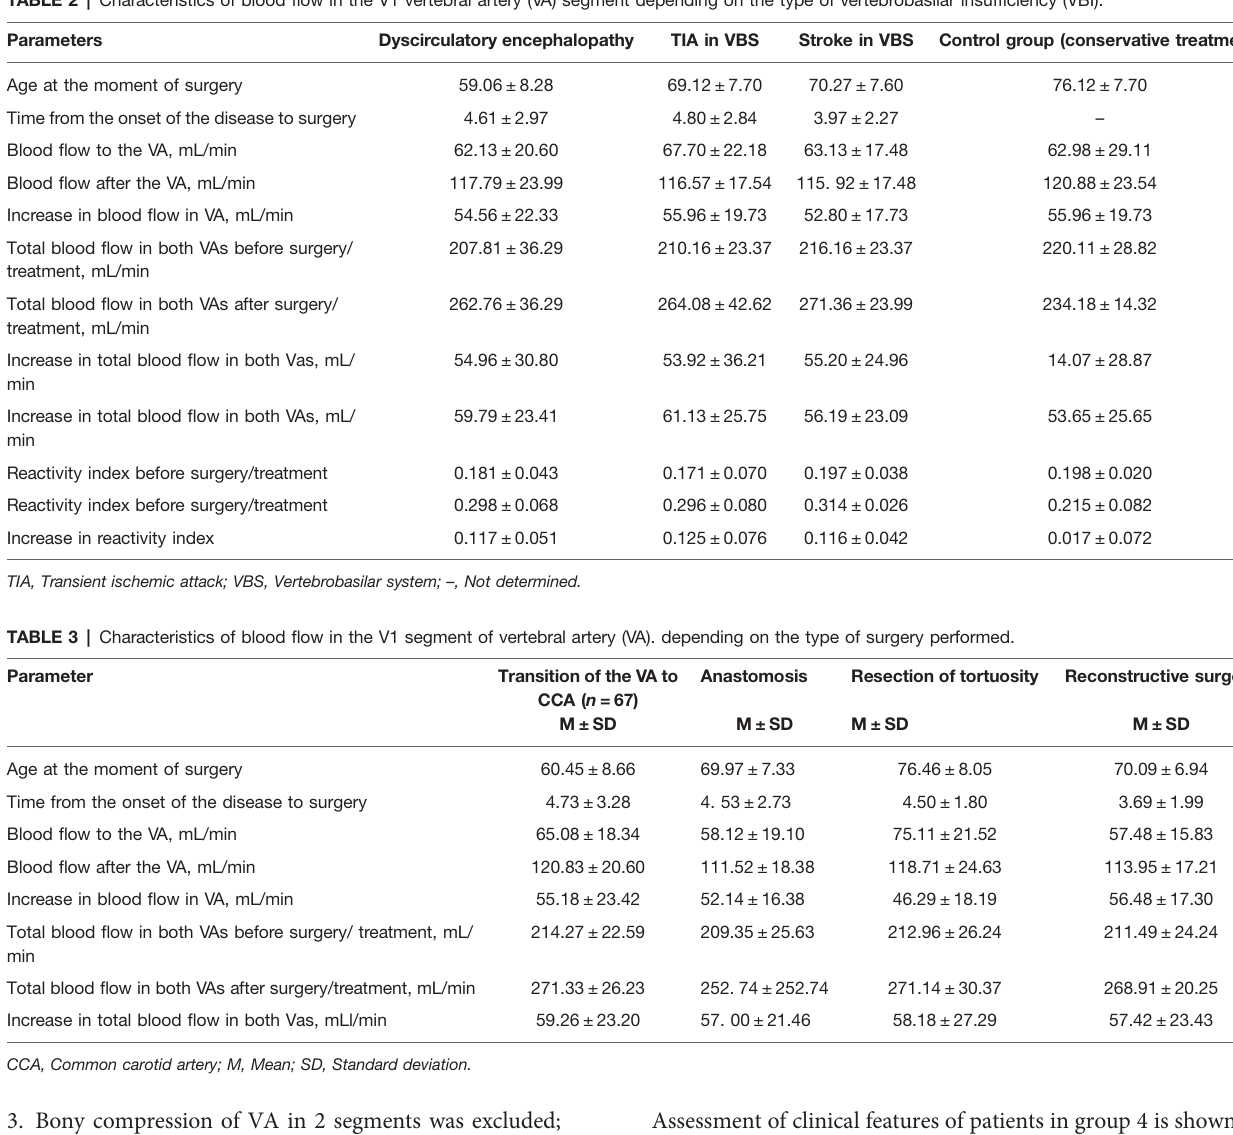
TABLE 2 | Characteristics of blood fl ow in the V1 vertebral artery (VA) segment depending on the type of vertebrobasilar insuf fi ciency (VBI).